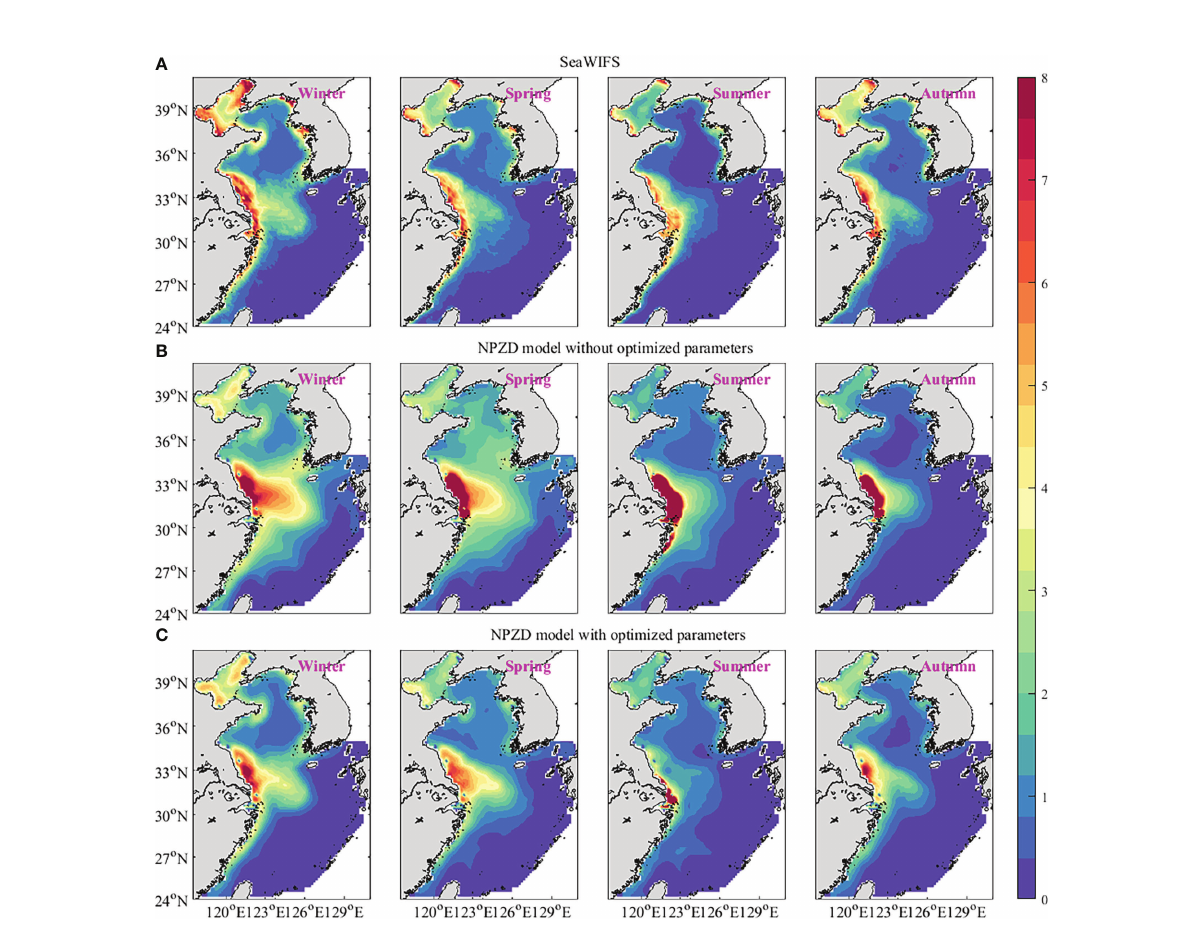
FIGURE 8 The sea surface phytoplankton obtained from SeaWiFS data (A) , simulations of the NPZD model without optimized parameters (B) and simulations of the NPZD model without optimized parameters (C) . (unit: mmol N·m -3